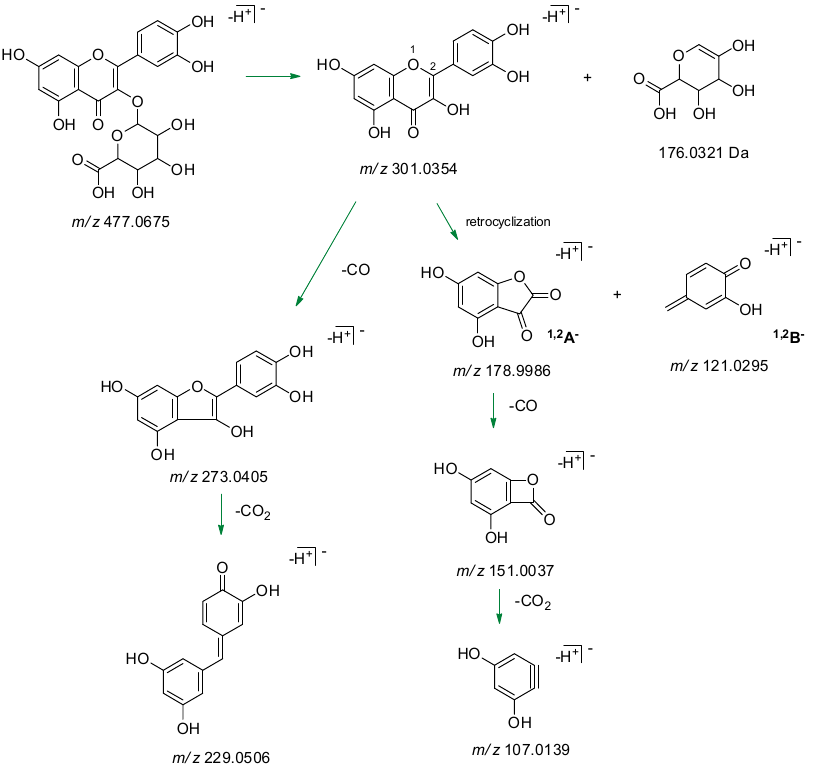
Figure 6. (A ) TOF-MS and ( B ) TOF-MS 2 spectra of the quercetin-3- O -glucuronide. ( C ) Quercetin-3- O - glucoside TOF-MS 2 spectrum. When [aglycone – H] – ion dissociated (spectrum not shown), it provided, with relative abundance of 20%, the ion at m / z 151.0039 (calcd. 151.0337). The latter is the result of a loss of CO